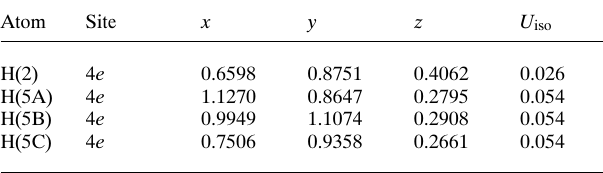
Table 2. Atomic coordinates and displacement parameters (in Å 2 )